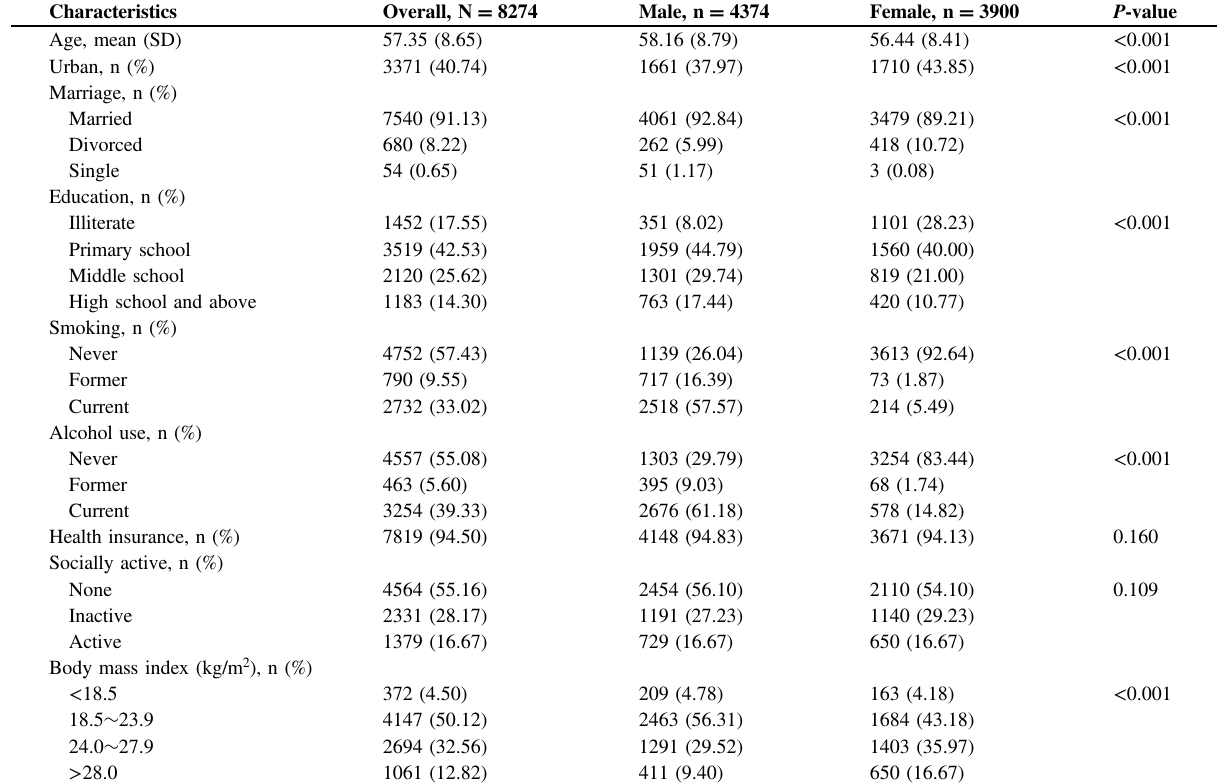
Table 1 Descriptive statistics for eligible individuals at baseline